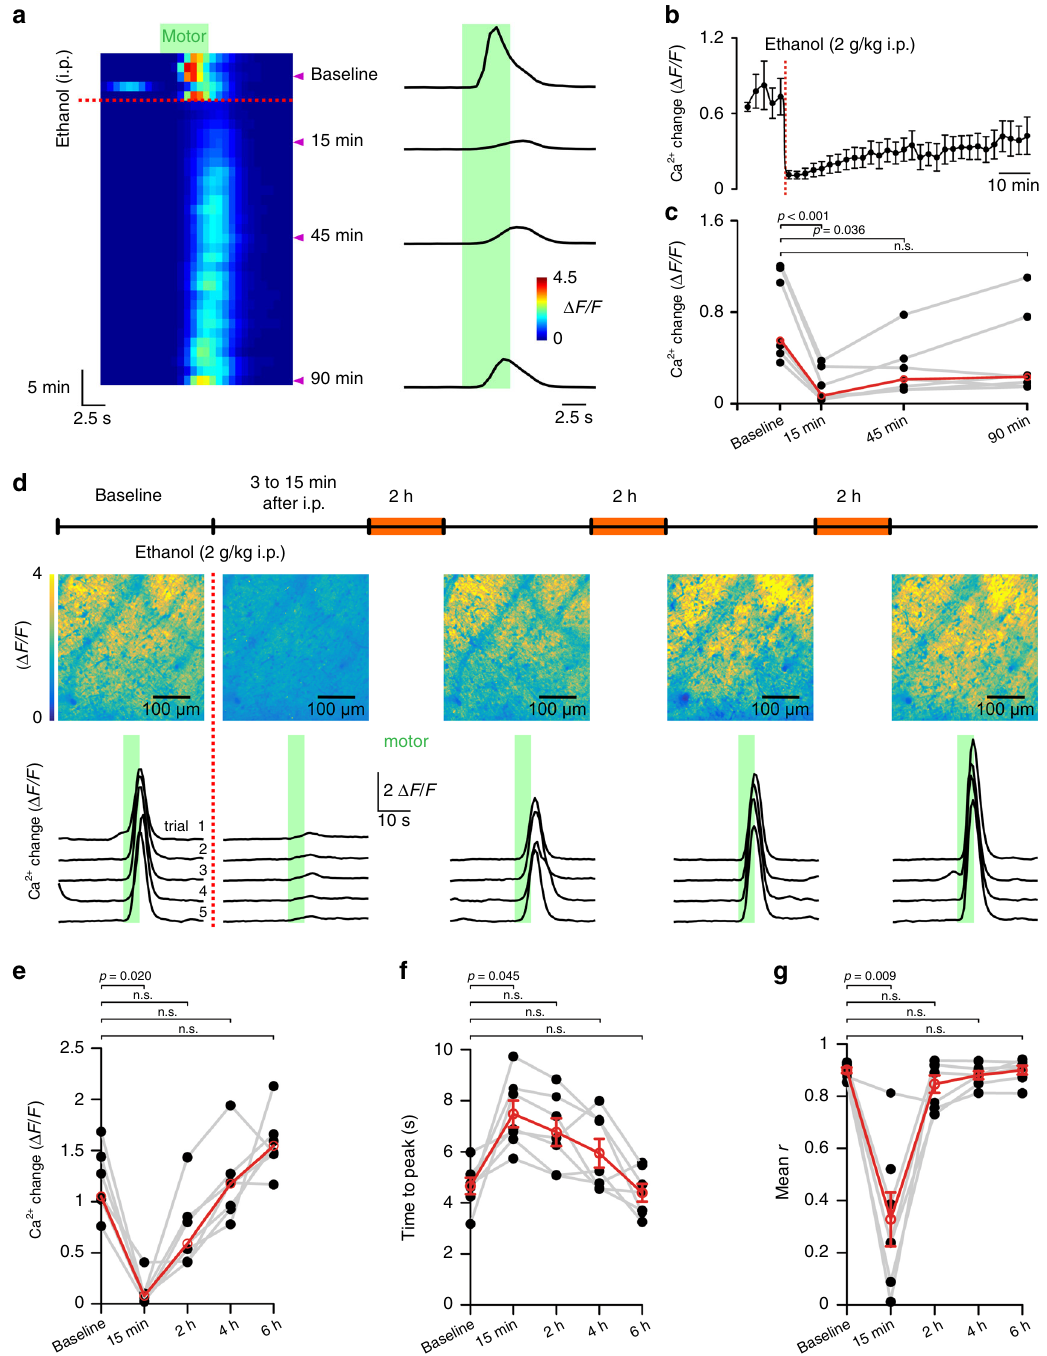
Fig. 2 Vigilance-dependent BG Ca 2 + activation recovers from ethanol inhibition within 6 h. a Left, Pseudocolour plot of time course of Ca 2 + responses of BG processes of Aldh1l1 - CreER T2 ; R26-lsl-GCaMP6f(Ai95) mouse. Each row represents average Ca 2 + response to one trial of enforced locomotion (green bar) of all ROIs determined as in Fig. 1. Ca 2 + responses to consecutive locomotion trials are vertically concatenated. Red dotted line indicates injection of 2 g/kg i.p. ethanol. Right, Representative Ca 2 + response traces of the trials indicated by purple arrowheads. b Time course of mean ± SEM Δ F / F 10s values from seven mice. c Ca 2 + responses at indicated time points following ethanol injection with baseline representing the average of fi ve trials. Red symbols indicate median from seven mice. n.s. not signi fi cant; Friedman test followed by Tukey – Kramer correction. d Upper, Maximum response plots of BG processes at indicated time points (seven independent experimental repetitions with similar results). Lower, Staggered overlay of Ca 2 + response traces at 200 s intervals within the respective time window. e – g Population data: mean Δ F / F 10s ( e ), mean time to peak ( f ), and mean correlation coef fi cient ( r ) ( g ) within indicated time windows. Red symbols indicate median ( e ) or mean ± SEM ( f , g ) from seven mice. Friedman test ( e ) and repeated measures ANOVA ( f , F (4, 24) = 10.606, p < 0.001 and g F (4, 24) = 26.949, p < 0.001) were followed by Tukey – Kramer correction; n.s. not signi fi cant. Source data are provided as a Source Data fi